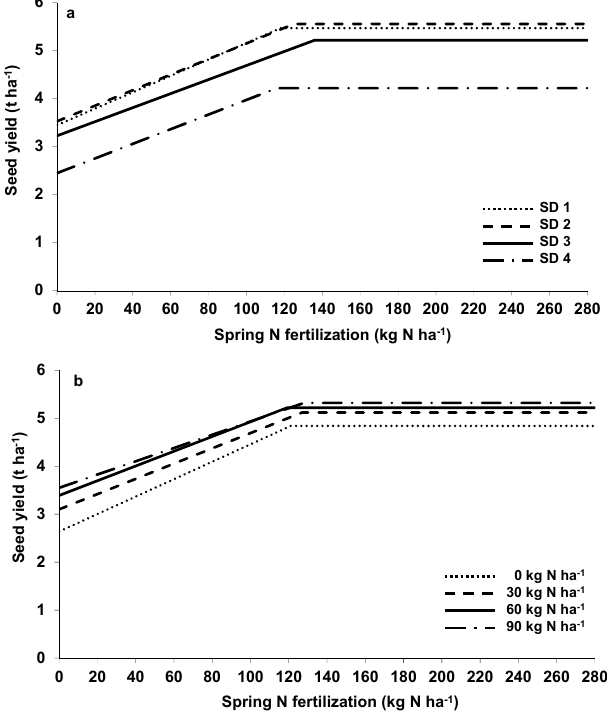
Figure 1. Effect of sowing method (SD) by spring N fertilization interaction ( a ) and autumn N by spring N fertilization ( b ) on seed yield of oilseed rape (2010, 2011, 2013; for function parameters, see Table 2). (SD 1—first week of August; S—third week of August; S—first week of September; S—third week of September). Table 2. Estimated model parameters of the linear ‐ plateau functions quantifying the relationship